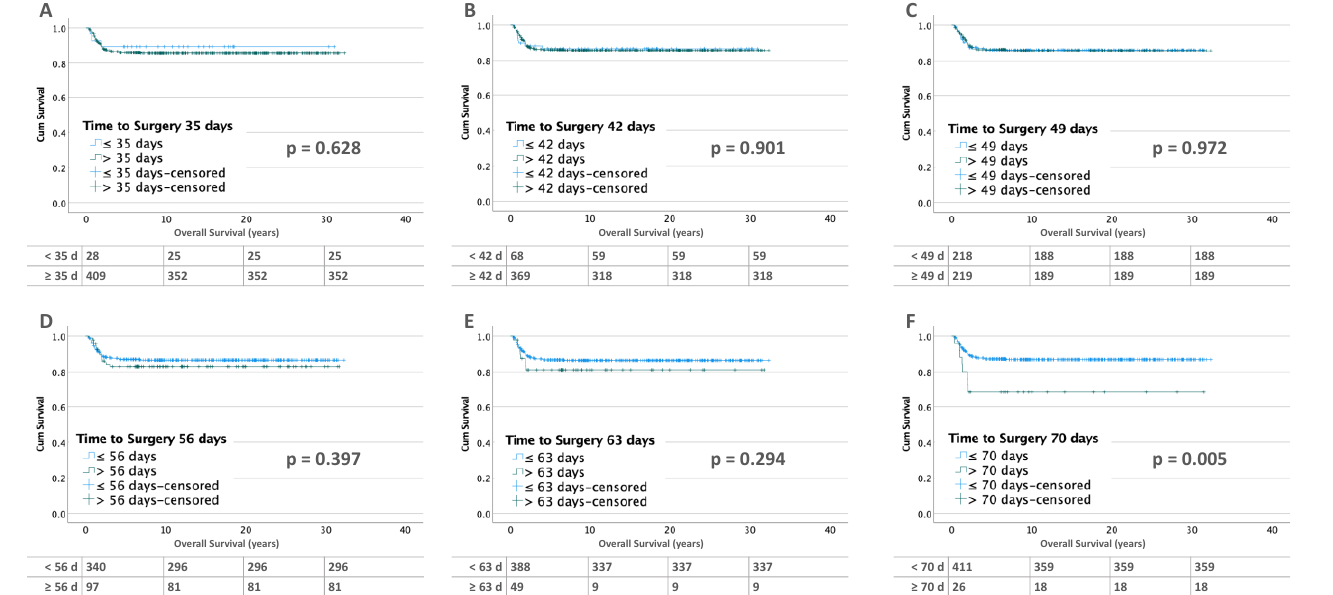
Figure 7. Kaplan – Meier lifetables of OS of unilateral WT with metastases at diagnosis at thresholds of 35 ( A ), 42 ( B ), 49 ( C ), 56 ( D ), 63 ( E ) and 70 ( F ) days of preoperative chemotherapy. In the tables below the figures, the numbers at risk are reported.